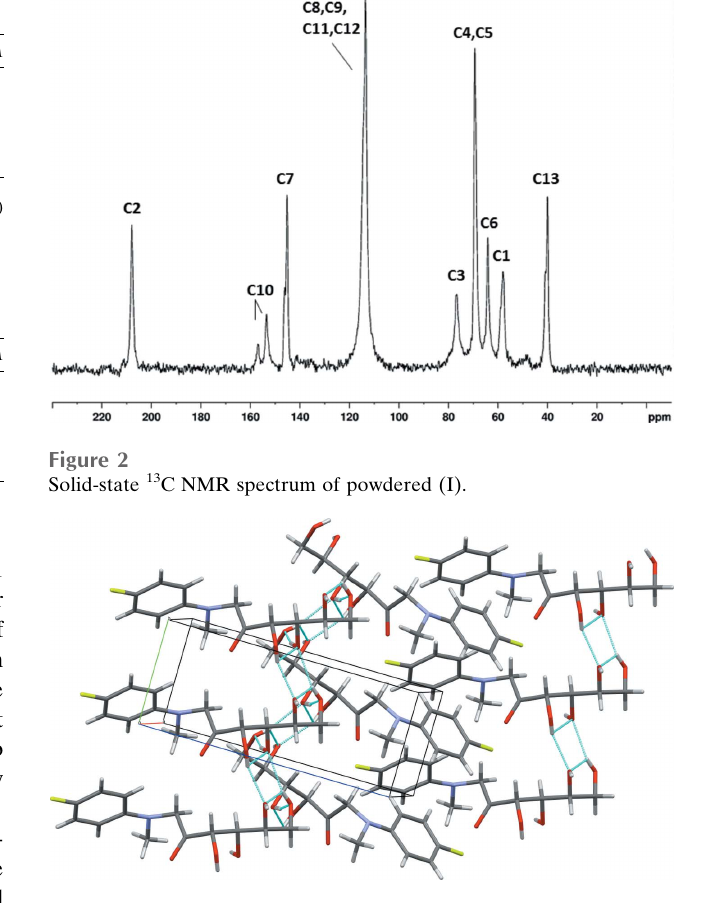
Figure 3 The molecular packing in (I). Color code for crystallographic axes: red – a , green – b , blue – c . Hydrogen bonds are shown as cyan dotted lines.